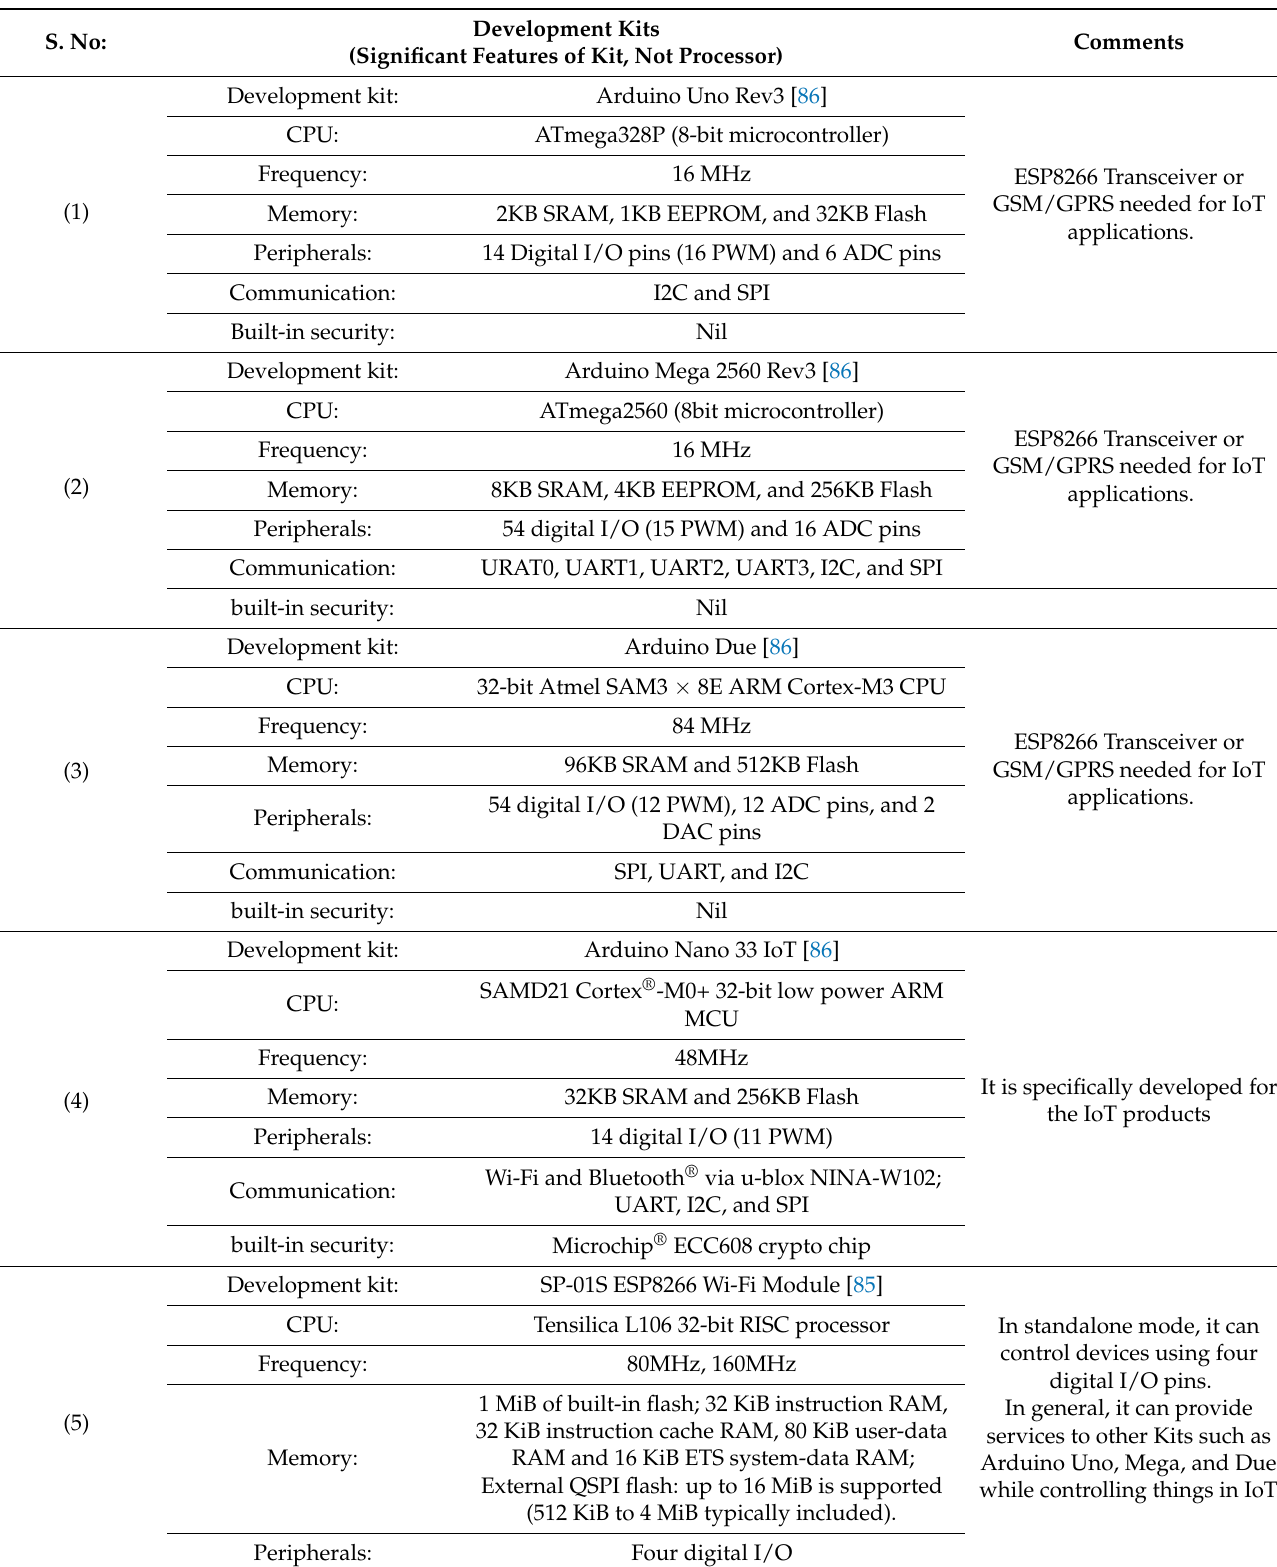
Table 5. A comparison of contemporary electronics development